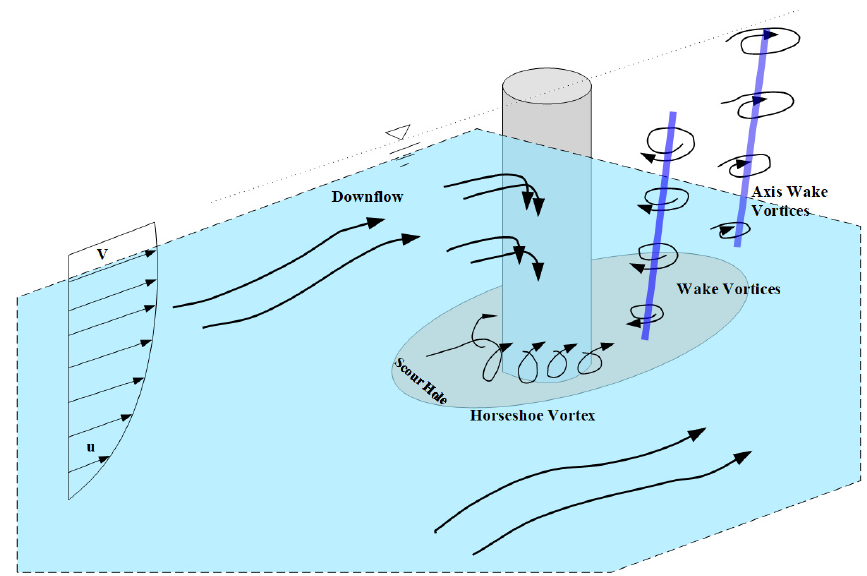
Figure A1. Flow mechanics around piles subjected to water current.